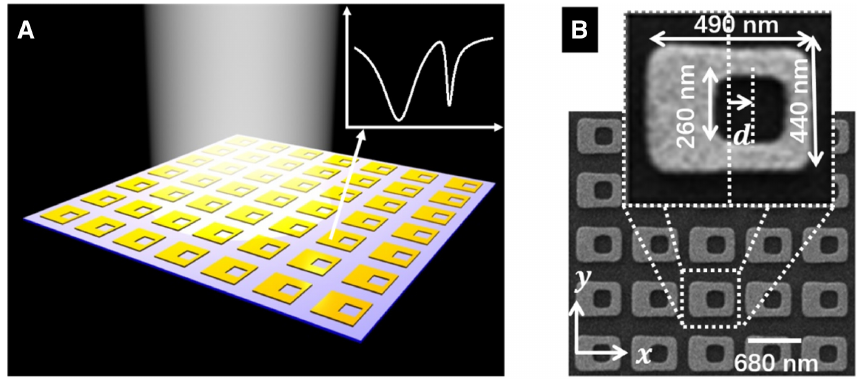
Figure 1: Schematic of the coupled plasmonic system. (A) The investigated samples that exhibit “Fano-like” resonances in the NIR regime. (B) SEM image of part of one fabricated